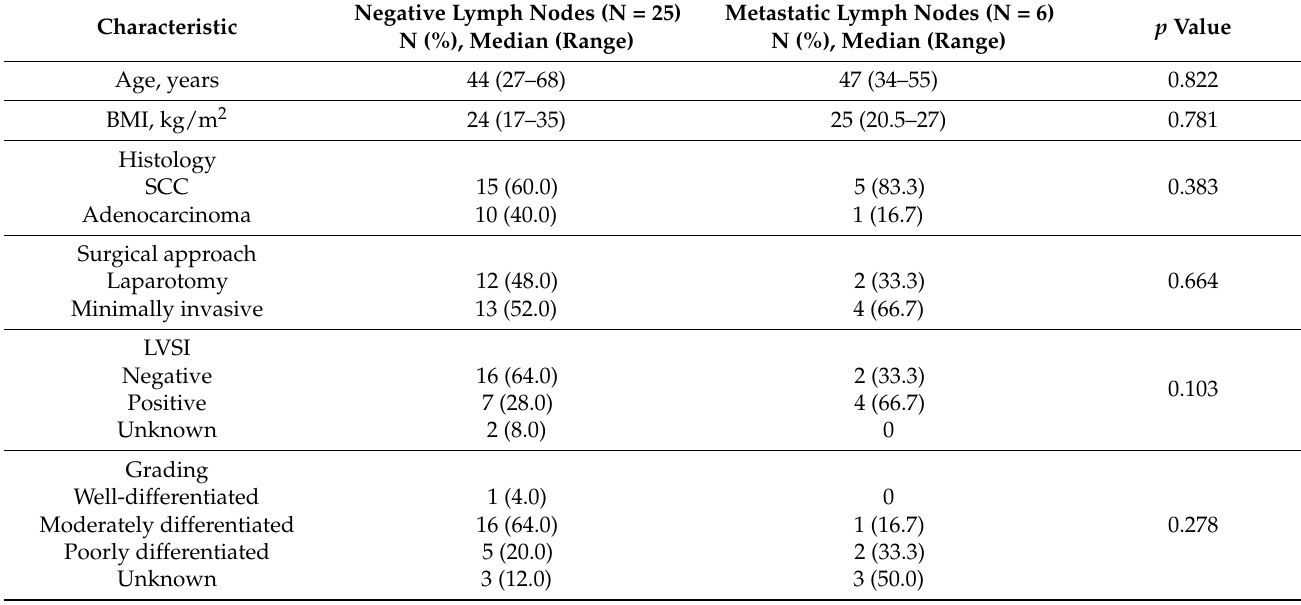
Table 2. Comparison of characteristics of patients with and without metastatic pelvic lymph nodes (ITC and micro- and